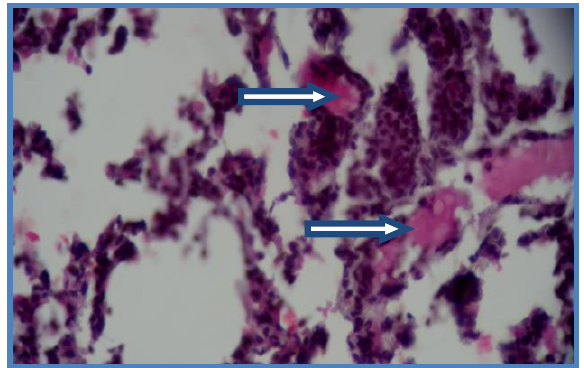
Figure , 2: Odema, Congestion of Capillary of Alveolar Cells and Infiltration of Polymorphonuclear Cells in the Alveolar Cells of Mice Lung after 5 Days of Infection with Isolated BPIV-3 Stained with (H and E ) (100X).